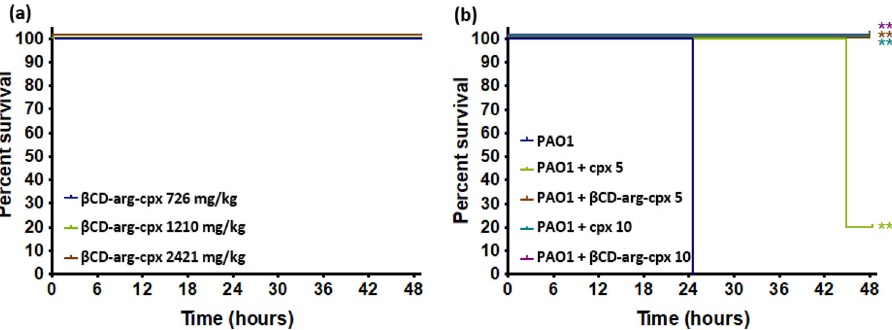
Fig. 9 Kaplan – Meier survival curves for in vivo toxicity and ef fi cacy in the Galleria mellonella larva model. Toxicity of β CD-arg-cpx complex showing very high larval survival for the whole concentration range tested (up to 2421 mg/kg) ( a ). Comparative antibacterial ef fi cacy study in larvae infected with PAO1 (dark blue) and treated with the β CD-arg-cpx complex (light green and brown) and free cpx drug (dark green and purple) (equivalent cpx content of 5 and 10 mg cpx/kg larva, respectively) that shows higher survival of the preinfected worms after treatment with the complex ( b ). Asterisks: statistically signi fi cant differences versus P. aeruginosa PAO1 control in a log-rank test (** p value < 0.01); n = 5. This fi gure represents the same experiment repeated several times, which yielded identical results every